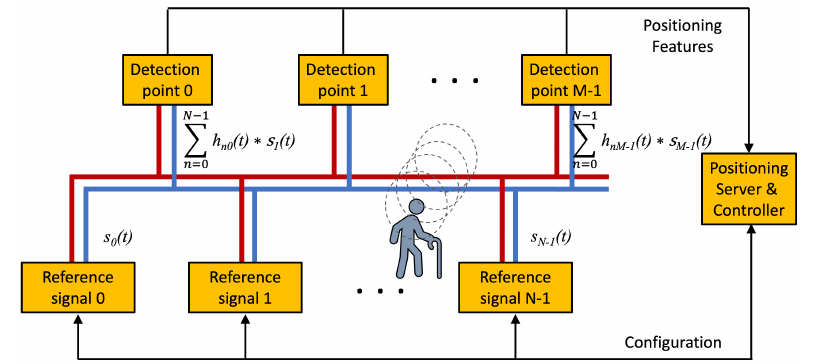
Figure 6. Basic scheme for Infra-based Target-obtuse PLPS. Using PLC for IBTO